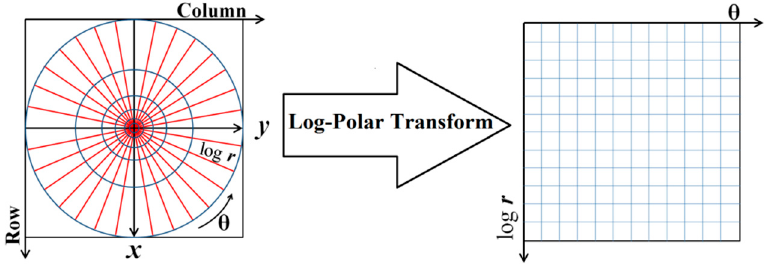
Figure 11. An example of SM between two sample images with shift difference.